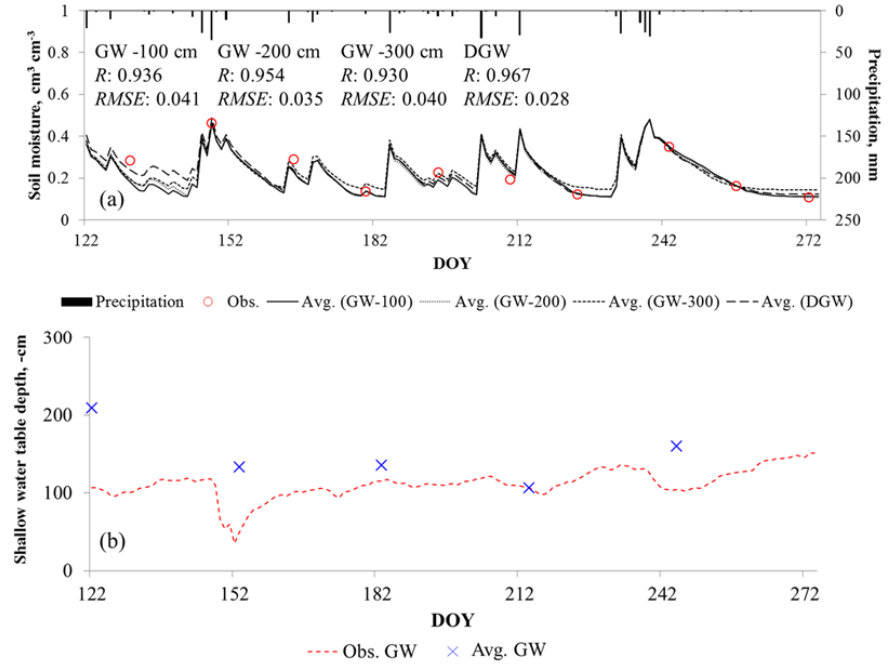
Figure 7. ( a ) Measured (in situ) and ensemble averaged root zone soil moisture; and ( b ) measured and estimated shallow ground water tables from fixed ground water (FGW) and DGW data assimilation schemes at Olney site (2004). Number in ensemble: 100.